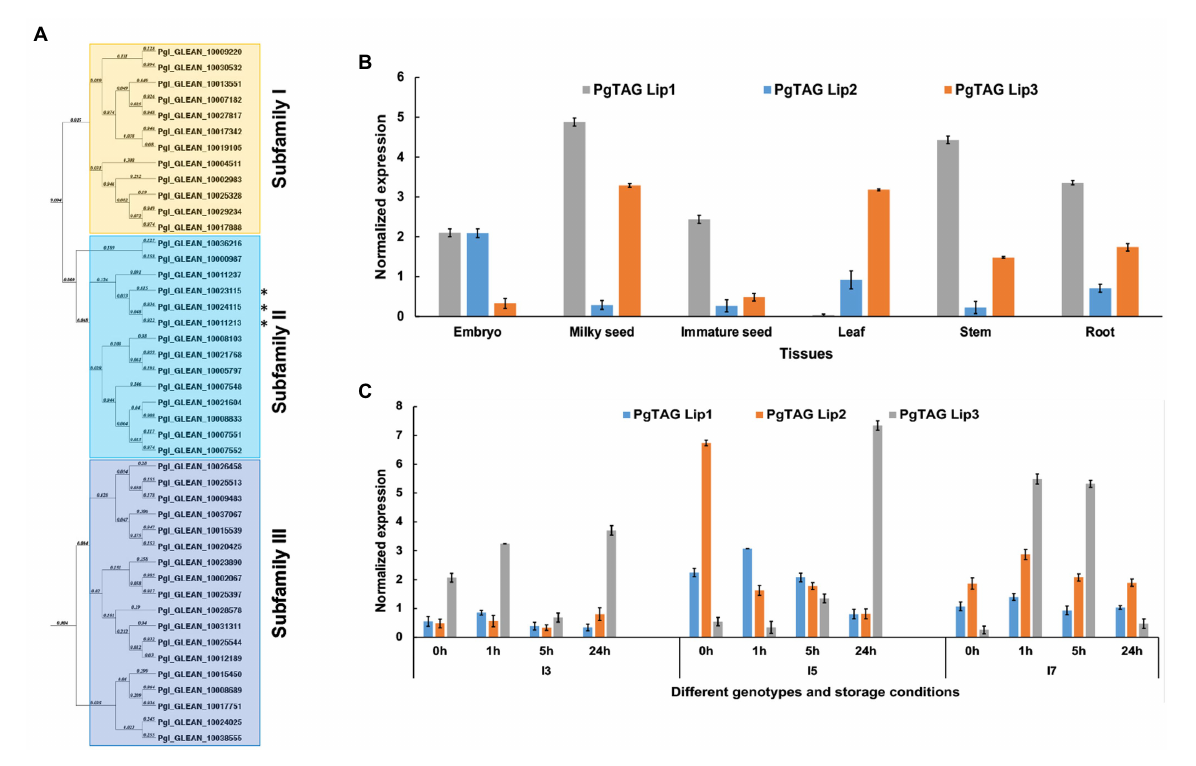
FIGURE 4 Phylogenetic relationships and expression analysis of the pearl millet lipases. (A) The phylogenetic tree constructed using MacVector software by the NJ method for PgTAGLips. Asterisks (*) denotes the genes used for further analysis: Pgl_GLEAN_10023115 was renamed Pg TAGLip1 , Pgl_ GLEAN_10024115 renamed Pg TAGLip2 , and Pgl_GLEAN_10011213 renamed Pg TAGLip3. (B) Expression analysis of three selected PgTAGLips in the various developmental stages of pearl millet variety ICMB 9333. Data points represent the expression values, obtained after normalization against the reference genes EUKARYOTIC INITIATION FACTOR4 Α ( PgEIF4 α ) and MALATE DEHYDROGENASE (PgMDH) . Each data point represents the mean of three biological replications with standard error (±SE; representing the mean of three technical replicates). (C) Expression of the selected PgTAGLips in contrasting genotypes (I3, I5, and I7) under accelerated storage of milled flour. The x-axis represents the identities of flour samples stored at 0 h, 1 h, 5 h, 24 h. The y-axis indicates the normalized gene expression values against the reference genes Pg EIF4 α and Pg MDH . Each data point represents the mean of three biological replications with standard error (±SE; representing the mean of three technical